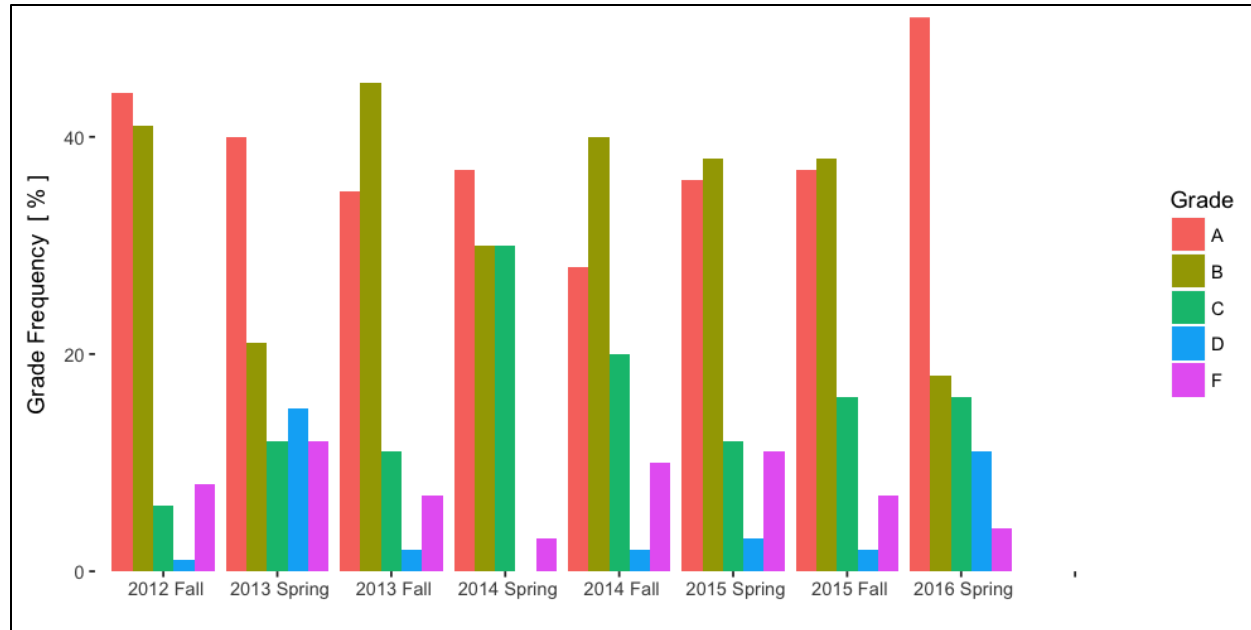
Figure 2 . Percentages of students earning Grades A-F in Physics 100, from Fall 2012 to Spring 2016. Fall terms are face-to-face versions of the course, and Spring terms are online, distance versions. See Appendix B for percentages in each